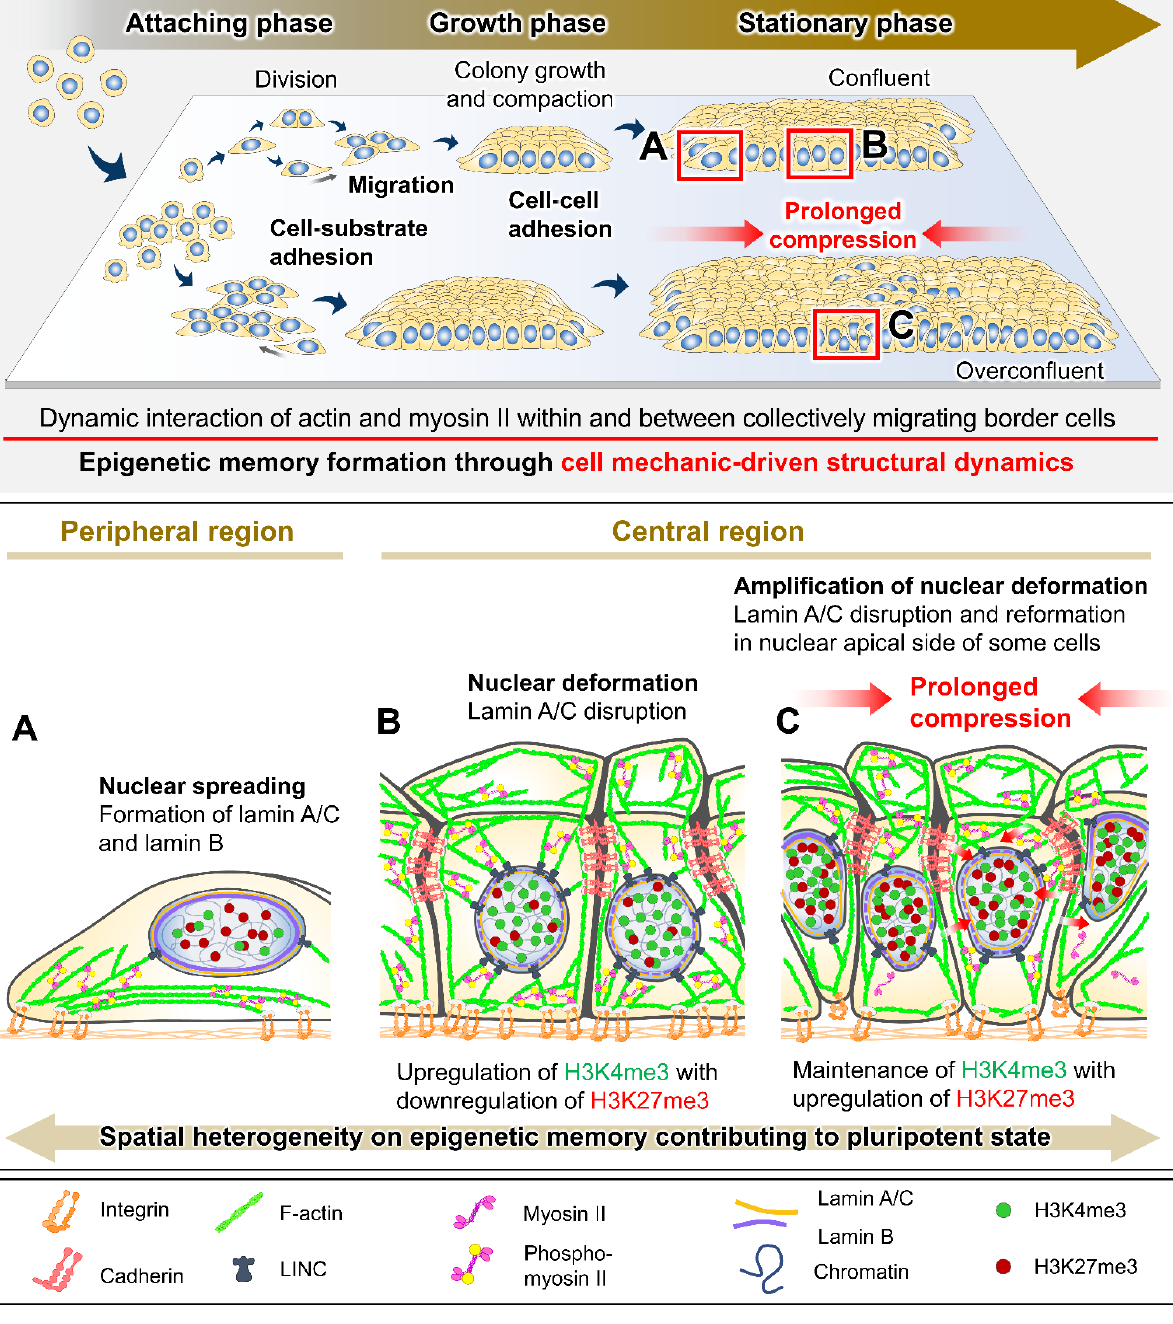
Figure 3. The impact of spatial heterogeneity on cell behavior-driven epigenetic memory. Position- and growth-dependent changes in cell behavioral characteristics during colony growth and com- paction in 2D monolayer culture ( A – C ) [17,18,24,68]. The differences in cell behavioral mechanics between the cells in different regions and different compressional constraints could distinctly in- duce the reorganization of the actomyosin cytoskeleton and nuclear laminas, leading to differences in nuclear structural deformation and epigenetic modifications [20,24]. The local heterogeneity within growing cell colonies ultimately contributes to the spatial transcriptional regulation of plu- ripotency-associated genes and possibly triggers deviation from the pluripotent state [17,19,67,68].